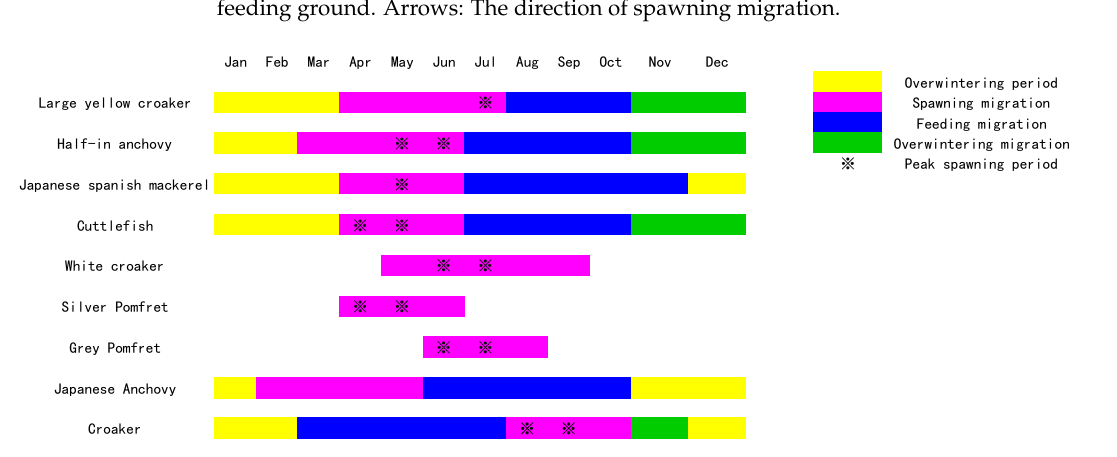
Figure 7. The growth period of nine main fish species in the study area.